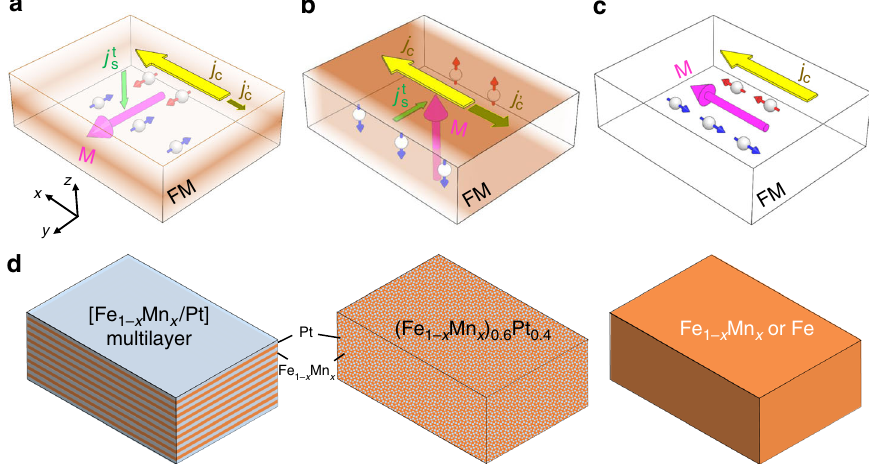
Fig. 1 Illustration of AHE and inverse AHE in thin FM fi lms and sample structures used in this study. AHE and inverse AHE in different magnetization con fi gurations: a , m || y ; b , m || z ; and c , m || x . d Schematics of three types of samples including co-sputtered (Fe 1 − x Mn x ) 0.6 Pt 0.4 , Fe 1 − x Mn x /Pt multilayer, Fe 1- x Mn x with x = 0.17 – 0.65 and Fe. The colormap in a – c is the distribution of net j t : the deeper the color the larger the net spin s